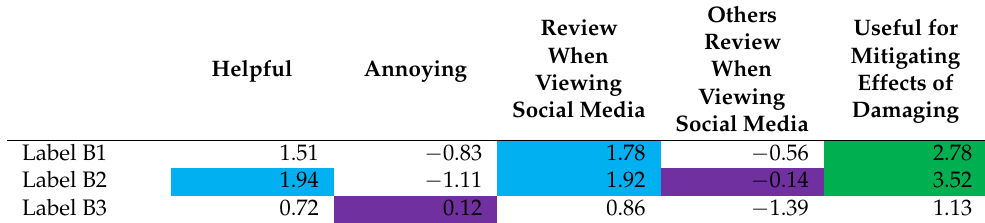
Table A2. Statistical significance calculations for Table 9 data.